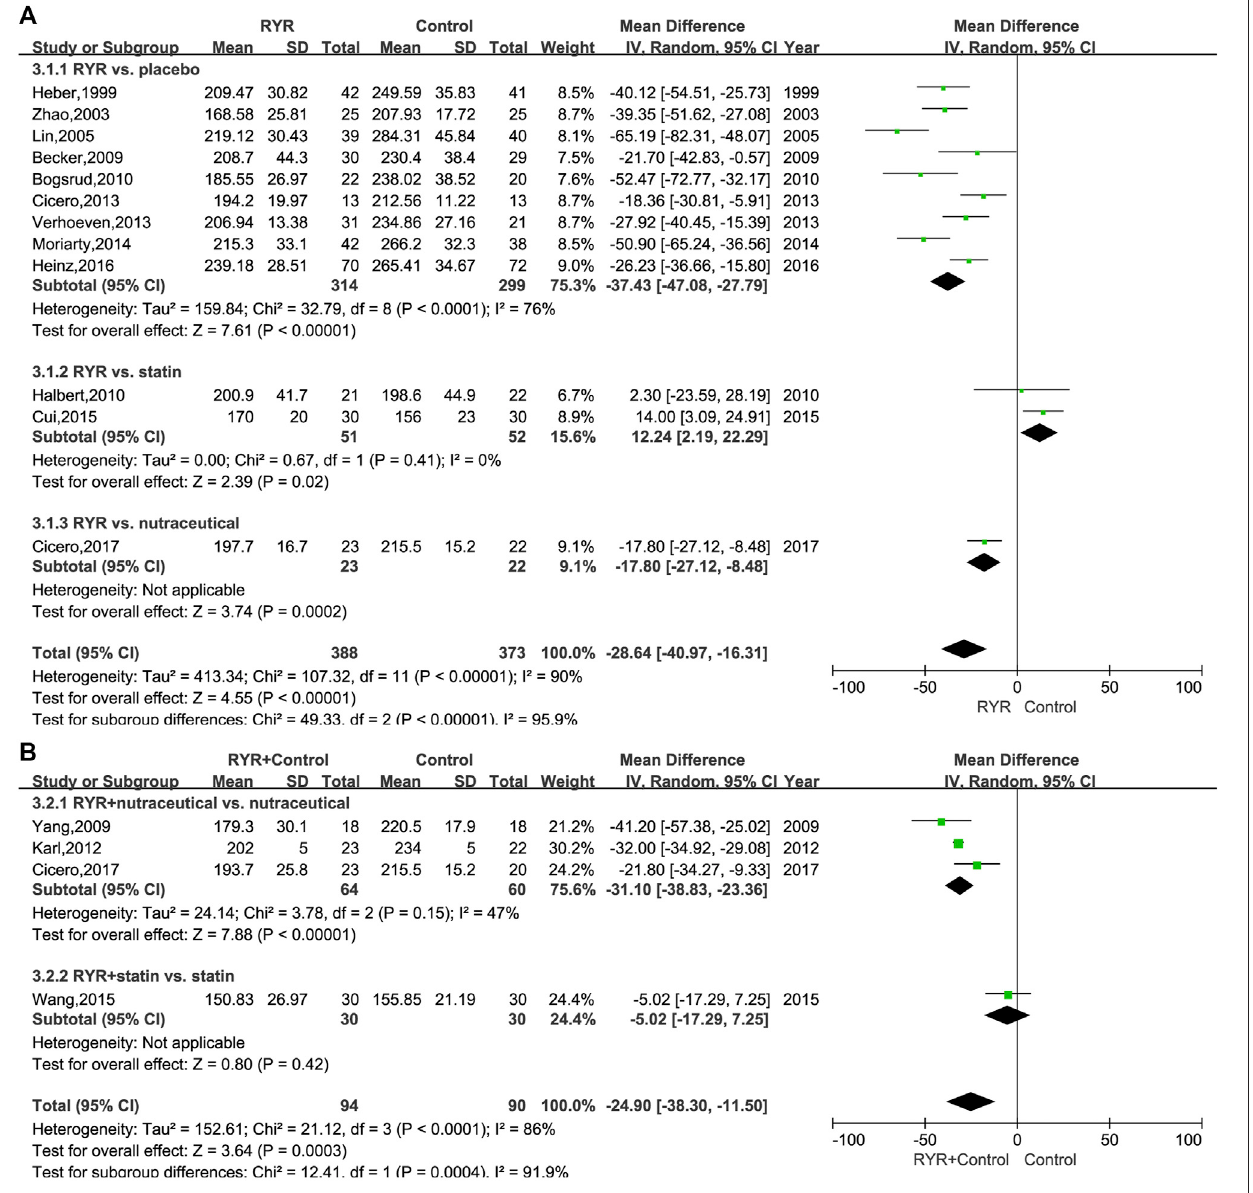
FIGURE 3 | (A) Forest plot of TC between RYR alone and control groups. (B) Forest plot of TC between RYR in combination and control groups. (RYR: red yeast rice; TC: total